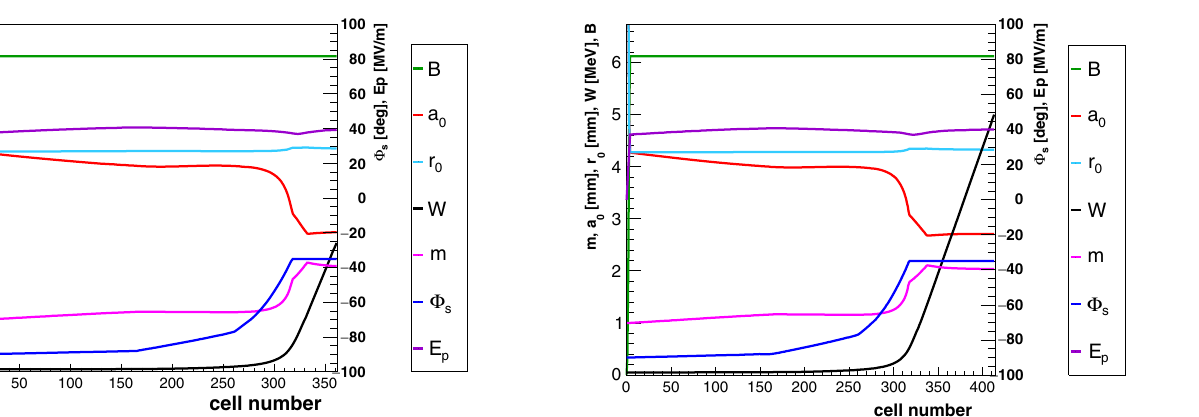
FIG. 20. Cell parameters for conceptual RFQ design of the 5- MeV proton accelerator proposed in this paper.